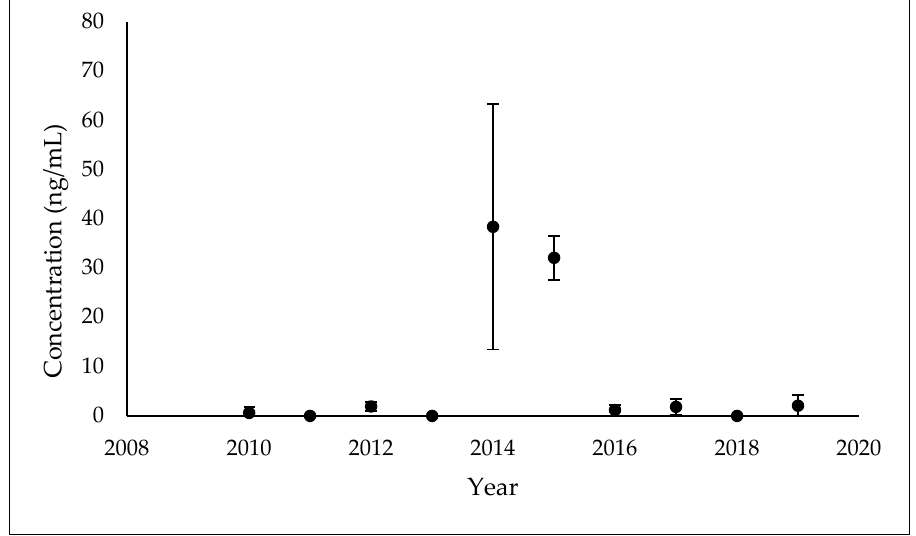
Figure 2. Mono(2-ethylhexyl) phthalate (MEHP) arithmetic mean concentration (dots; ng/mL) and standard deviation values (whiskers; ng/mL) for all bottlenose dolphins sampled from Sarasota Bay, Florida during 2010–2019 (values shown in Table 1). Of the 69 total samples, 13 dolphins were sampled more than once and are included in this figure to preliminarily identify natural groupings in the data.